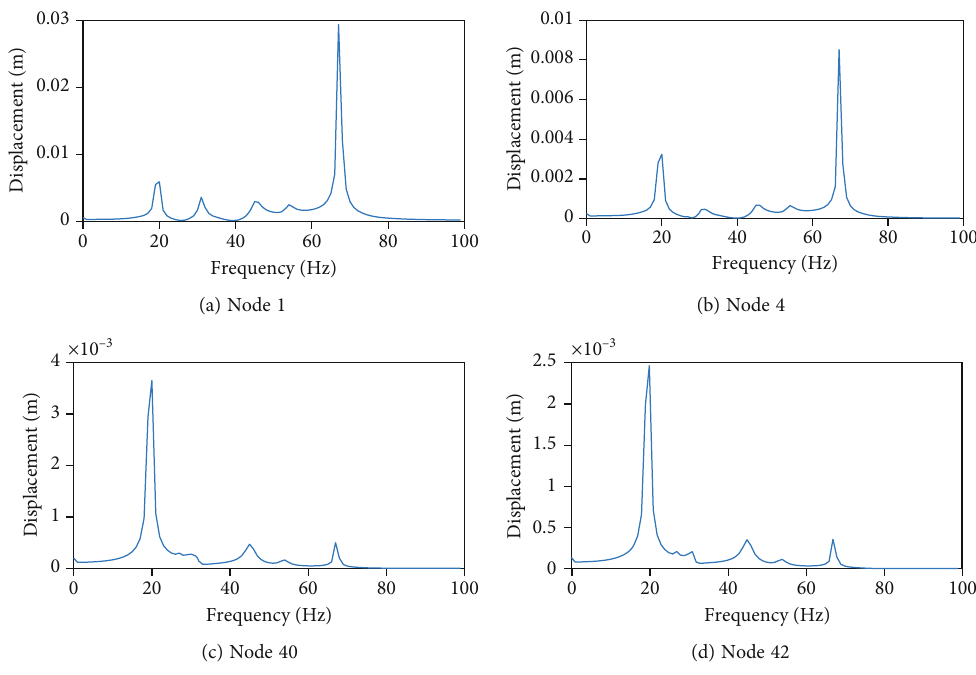
Figure 10: Response frequency analysis at key points in path 1.